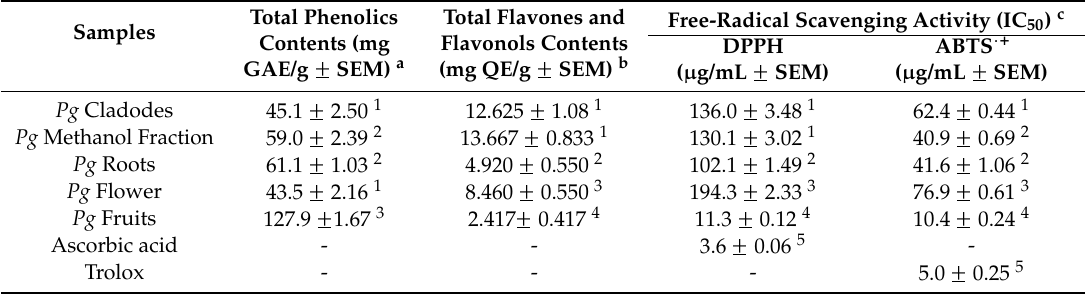
Table 2. Total phenolic, total flavones and flavonols contents and DPPH and ABTS free radical scavenging